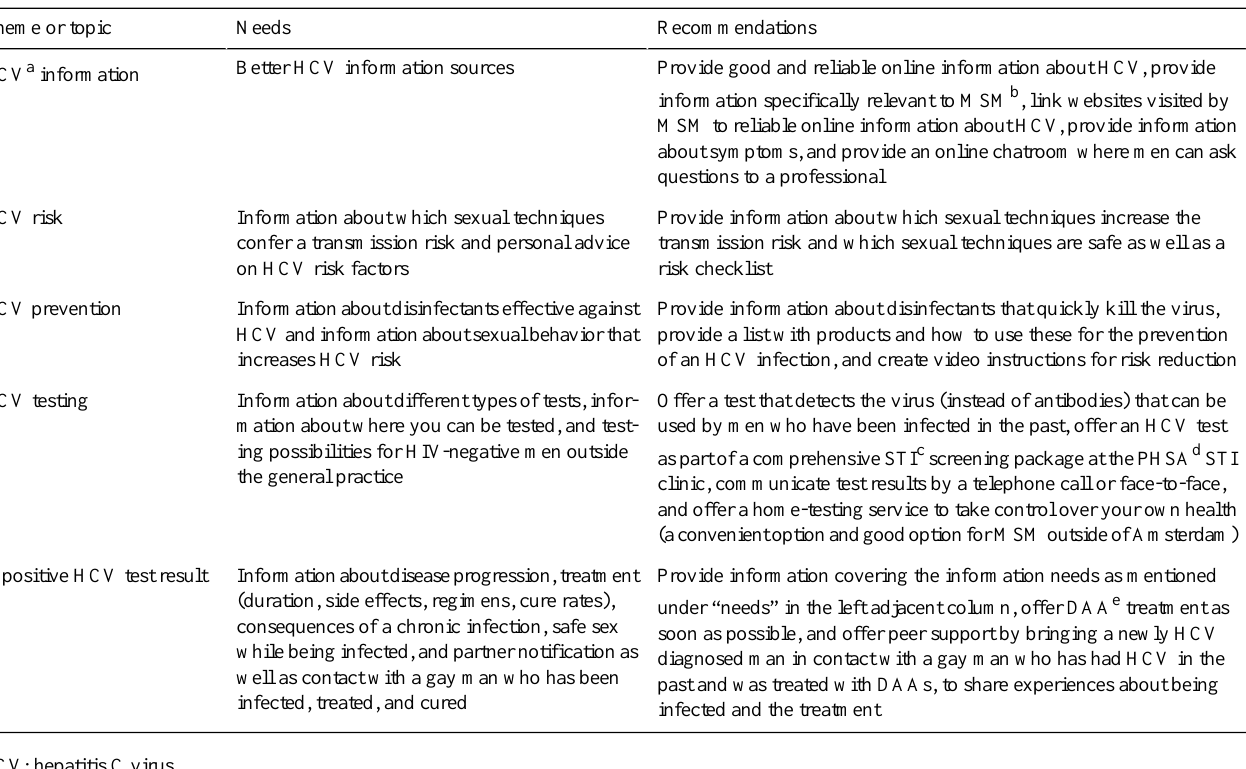
Table 2. Summary results of two focus group discussions determining the needs and recommendations regarding hepatitis C information and testing